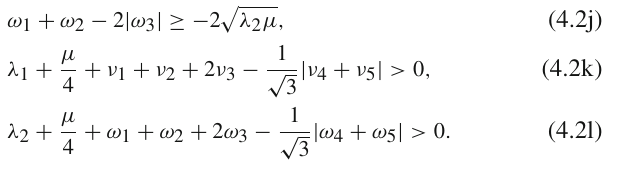
Fig. 7 Fermionic one-loop